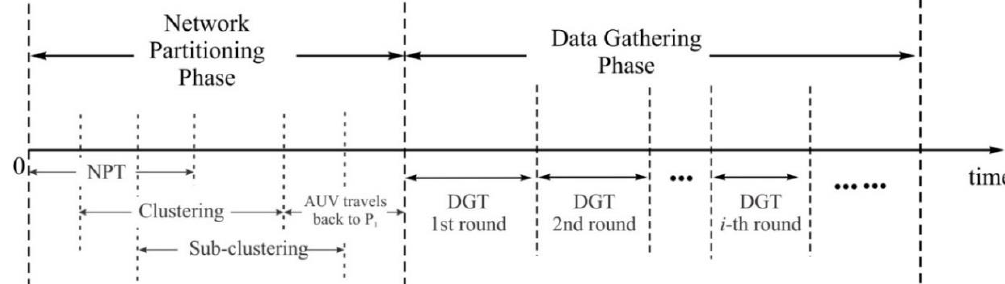
Figure 3. Timeline of the proposed